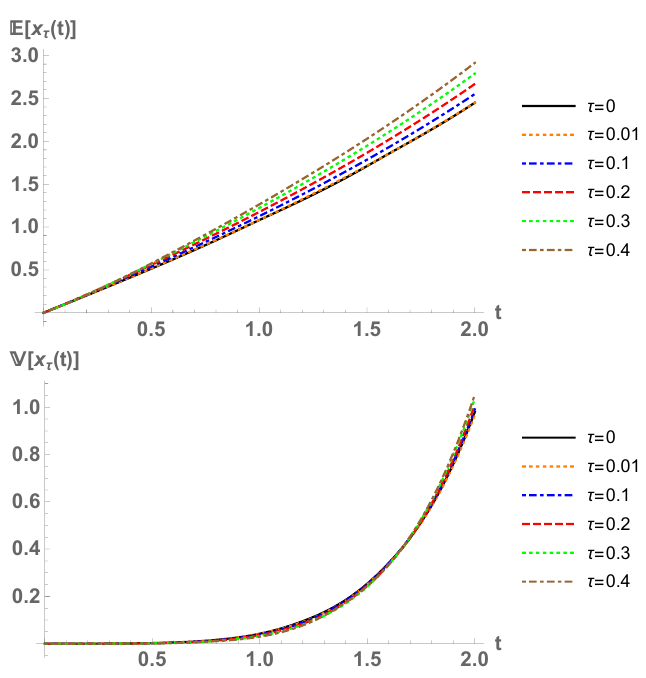
Figure 2. Expectation (up) and variance (down) of x τ ( t ) , Example